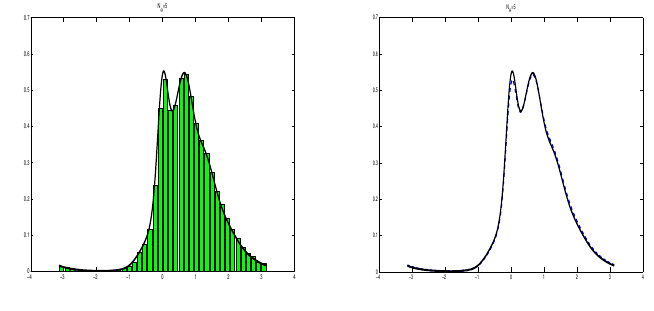
Figure 1. Left, result of the data fitting with N Θ = 3 rates. Histograms: experimental L´evy data collected in 40 bins. Solid line calculated PDF. Right, dashed line calculated PDF with the original 5 rates.